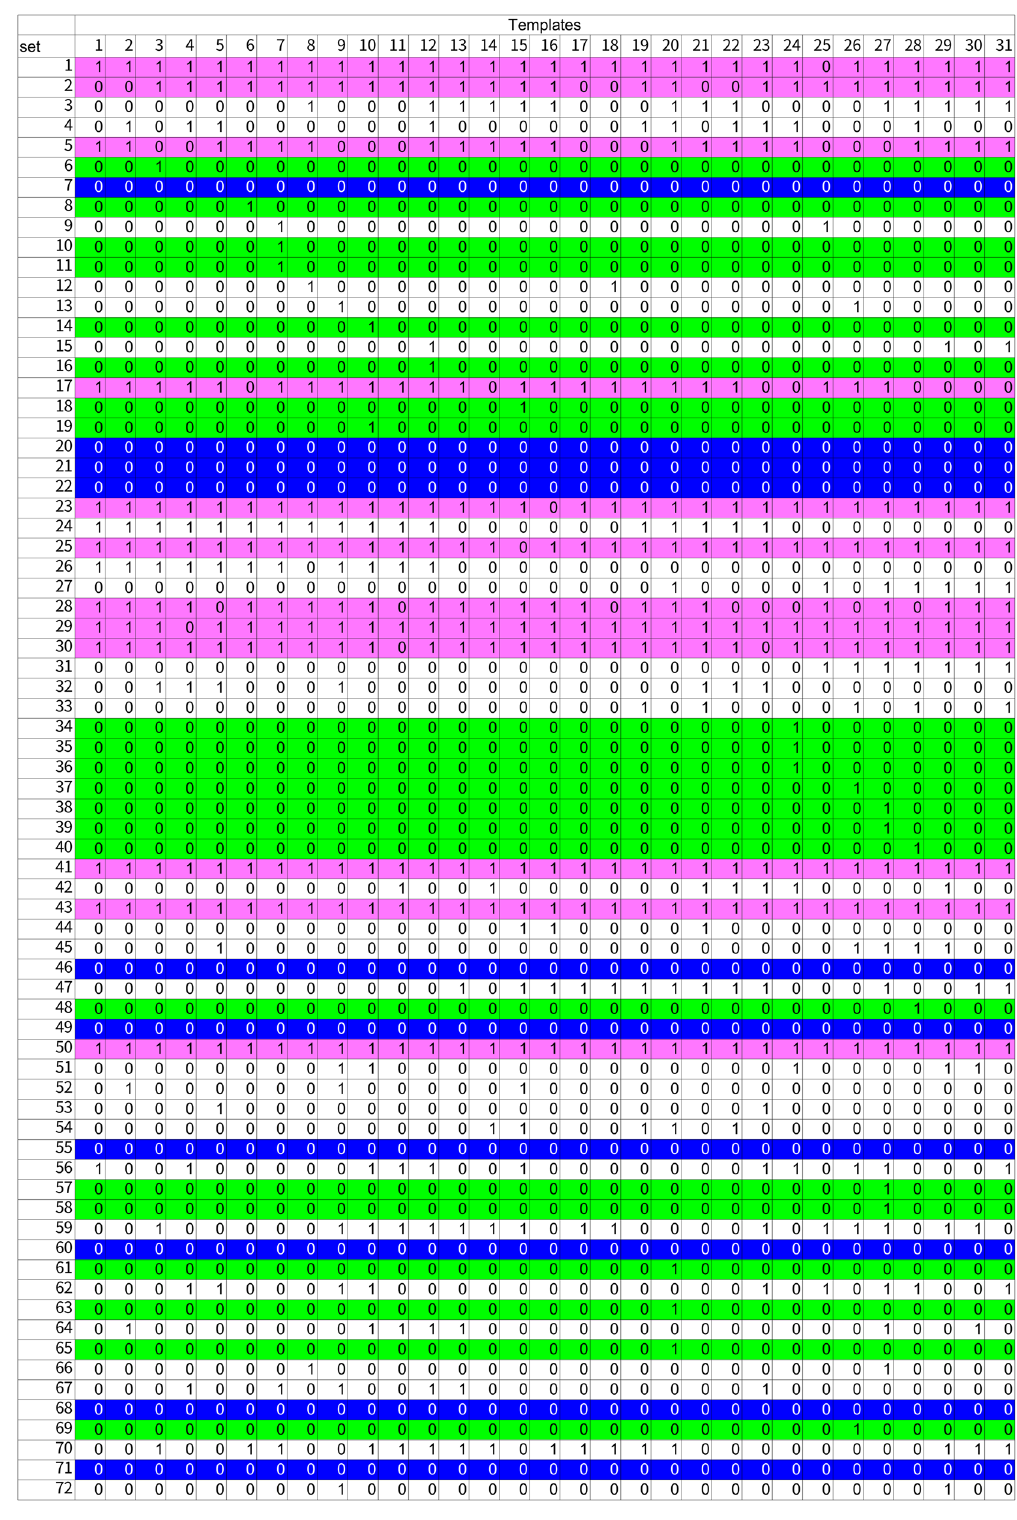
Table 4. PCR results with a combination of 72 primer sets and 31 templates. PCR results are expressed by the following numerical values based on observation on agarose gels. Number 0: No PCR product, 1: PCR product can be confirmed. Results on the primer pairs which have positive results on more than 20 templates are shown with pink background. Similarly, primer pairs which have results with single or no positive on 31 templates are shown with lime or blue background,